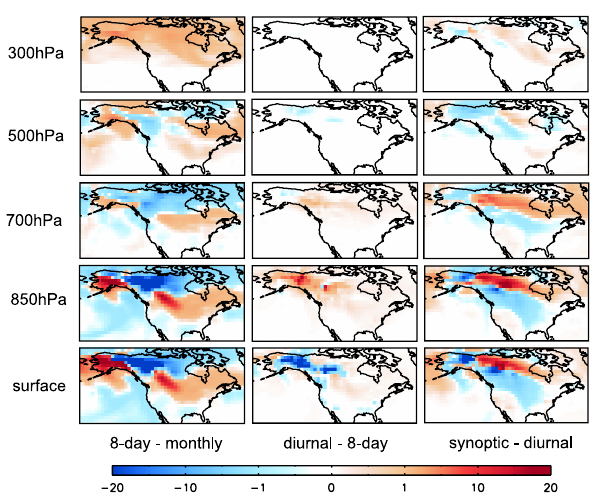
Fig. 5. Differences of model simulated 3-month (June– August 2004) average CO mixing ratios (ppbv) at five pressure lay- ers (surface, 850hPa, 700hPa, 500hPa, 300hPa) due to the adding of each temporal constraint on biomass burning